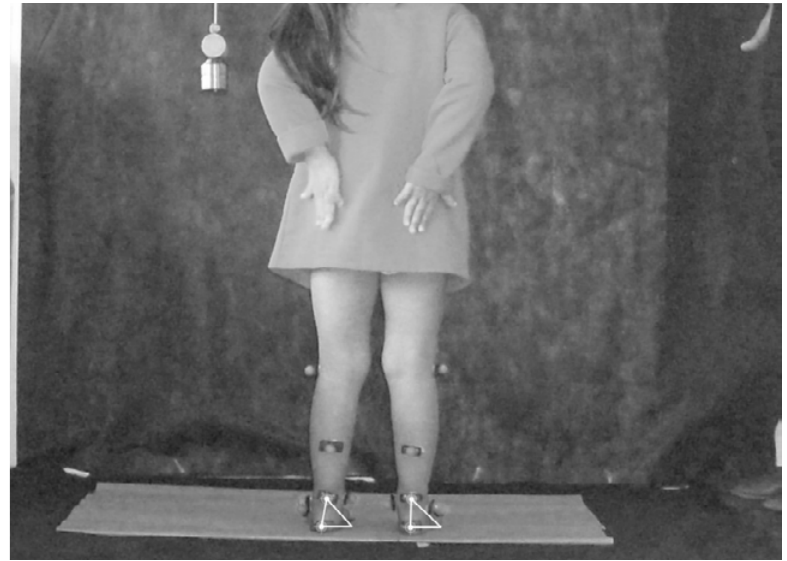
Figure 2 – Representative figure of the prone-supine angle evaluation through the SAPO software.